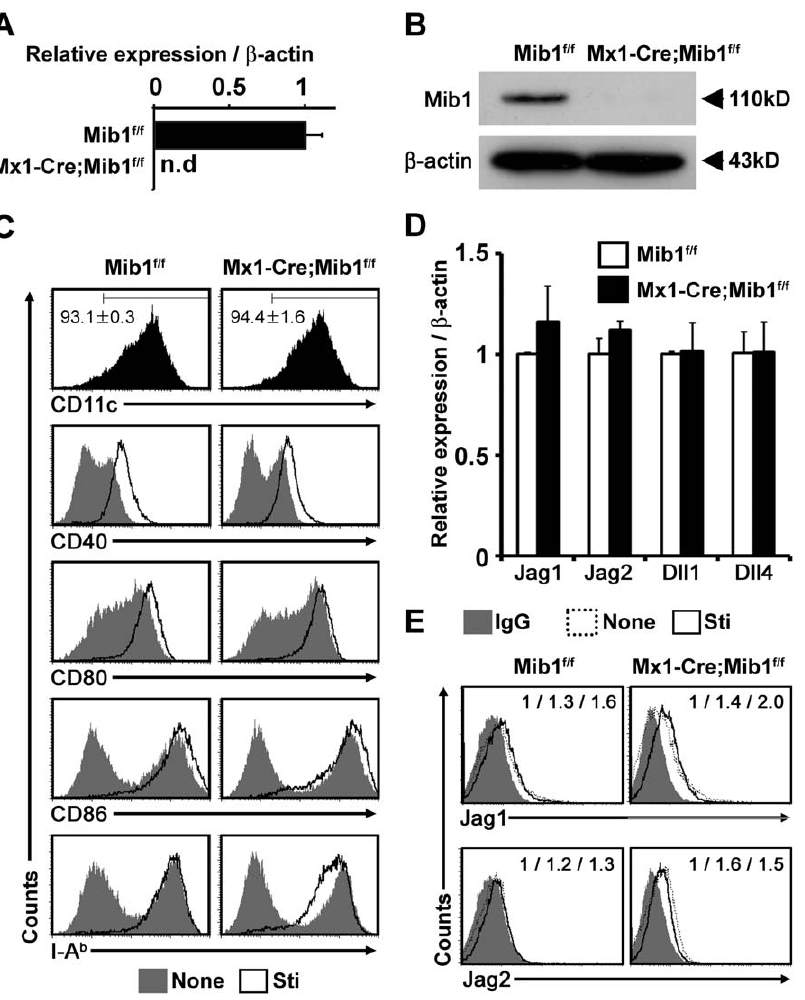
Figure 2. Generation of Mib1-null DCs. A and B , Quantitative real-time RT-PCR ( A ) and western blot ( B ) analyses of Mib1 in DCs from Mib1 f/f or Mx1-Cre;Mib1 f/f mice. C , Flow cytometry analysis for DC marker, CD11c, costimulatory molecules, CD40, CD80 (B7.1), and CD86 (B7.2), and MHC II (I-A b ) in Mib1 f/f or Mx1-Cre;Mib1 f/f DCs before ( None, gray-filled histogram ) or after LPS stimulation ( Sti, black line ). Numbers on flow cytometry plots represent the mean percentage of cells 6 SD. D , Quantitative real-time RT-PCR analysis of Notch ligands in LPS-stimulated DCs from Mib1 f/f and Mx1-Cre;Mib1 f/f mice. Results are representative of three independent experiments. E , Flow cytometry analysis for Jag1 and Jag2 in Mib1 f/f or Mx1-Cre;Mib1 f/f DCs. Numbers indicate the relative median fluorescence intensities of IgG isotype control ( IgG, gray-filled histogram ), DCs before LPS stimulation ( None, dotted line ), and DCs after LPS stimulation ( Sti, black line ), respectively, in each plots. Data represent mean 6 SD.